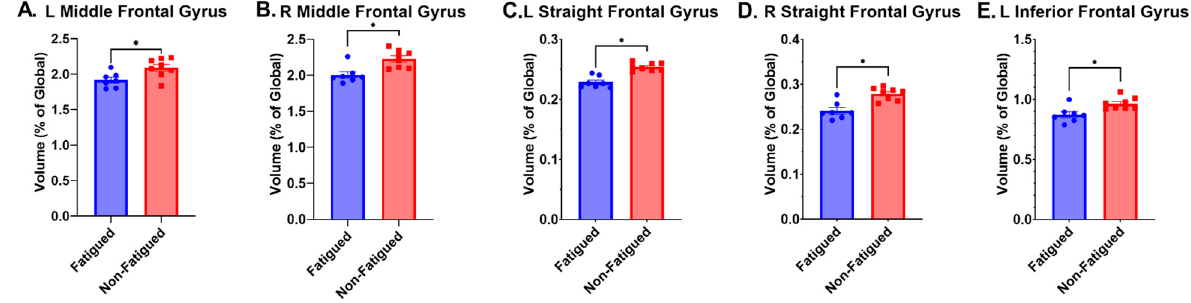
Figure 2. Regional volumetric comparisons for fatigued (blue) and non-fatigued (red) subjects > 6 months post-infection. Y axis is the percent of total volume (i.e., 1.5 = 1.5%). Dots represent individual data points. * Represents a p < 0.05. Data are means ± SEM. Fatigued subjects > 6 months post-infection had smaller relative volumes across each brain